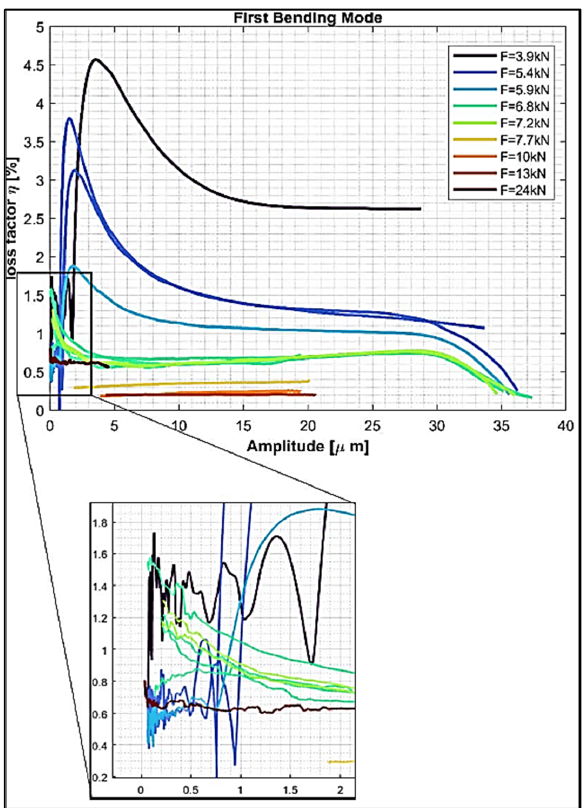
Figure 9. Damping as a function of vibration amplitude for first flexural mode. The variation of the frequency against the vibration amplitude is depicted in Figure 10.